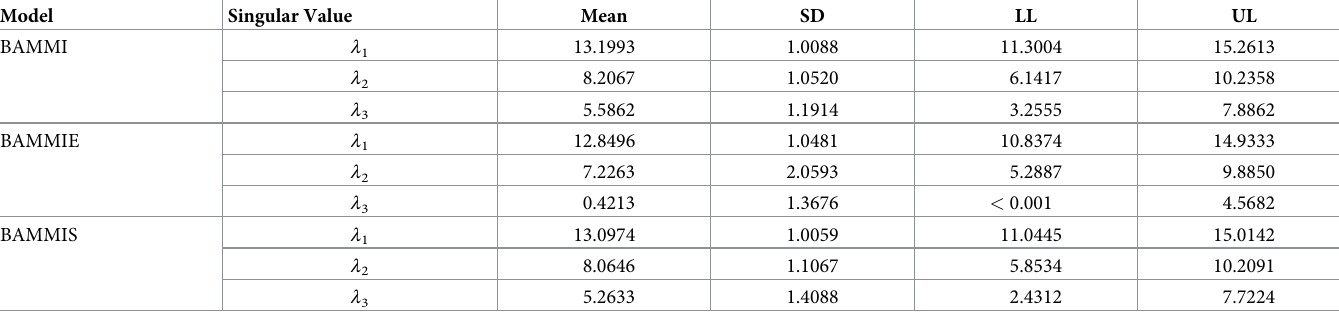
criteria, it was found that there are no major discrepancies about genotypic and residual vari- ances (S2 Table). In Fig 3, posterior means and HPD intervals at 95% of credibility of the genotypic effects for BAMMI, BAMMIS, and BAMMIE are presented considering conditional (blue color) and marginal (red color) responses. In both situations, the pattern in the classification of main Table 2. Estimated singular values for the AMMI model referring to the three hypotheses made under the interaction, using the RJMCMC algorithm.